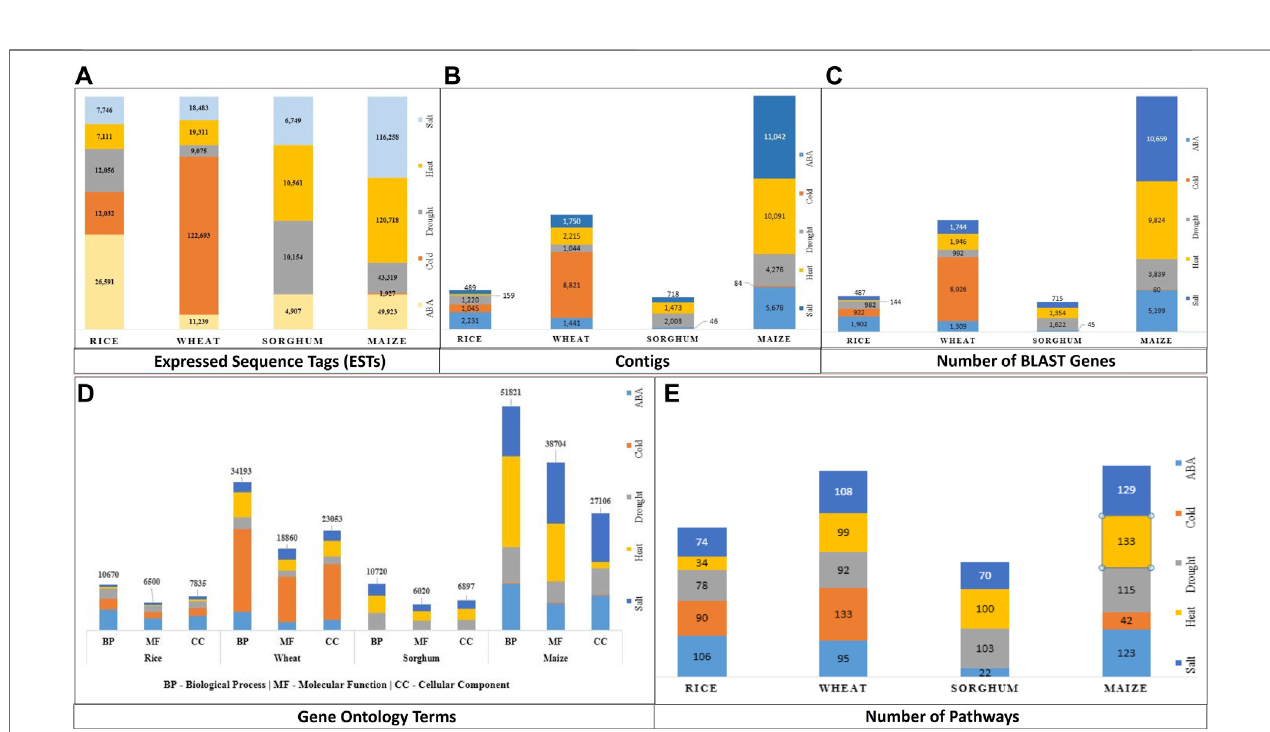
FIGURE 1 | Data Summary — (A) ESTs, (B) Annotated contigs along with their corresponding (C) BLAST genes, (D) GO term, and (E) Pathway (GO: Gene Ontology, BP, Biological process; MF, Molecular Function; CC, Cellular Components).